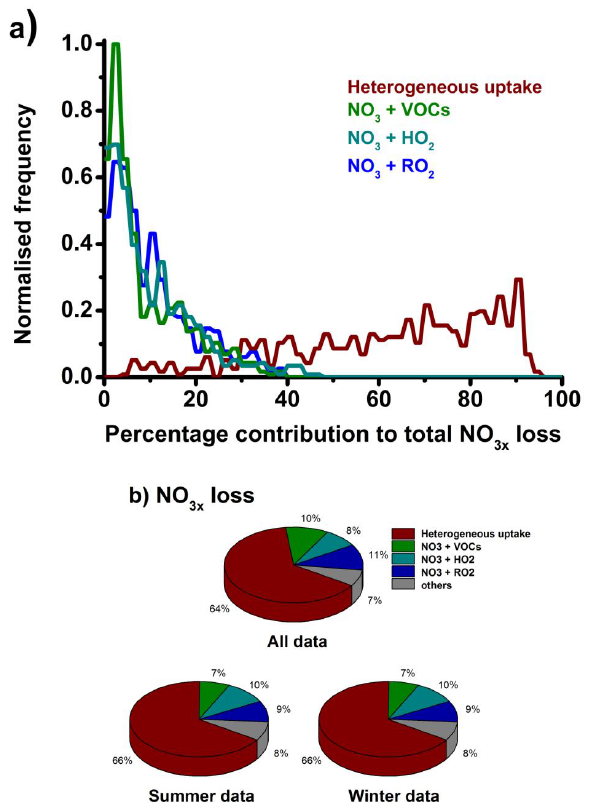
Fig. 6. Processes controlling losses of NO 3x (i.e. NO 3 + N 2 O 5 ) in the model, displayed as (a) the probability distribution func- tions for the percentage contributions to the total loss for hetero- Figure 6: Processes controlling losses of NO 3x (= NO 3 + N 2 O 5 ) in the model, displayed as (a) the geneous uptake of NO 3x to aerosol surfaces (red), NO 3 + VOCs probability distribution functions for the percentage contributions to the total loss for heterogeneous (green), NO 3 + HO 2 (light blue) and NO 3 + RO 2 (all organic uptake of NO 3x to aerosol surfaces (red), NO 3 + VOCs (green), NO 3 + HO 2 (light blue) and NO 3 + RO 2 peroxy radicals) (dark blue); and (b) the summer and win- (all organic peroxy radicals) (dark blue), and (b) the summer and winter campaign means combined ter campaign means combined (upper panel), summer campaign (upper panel), summer campaign mean (lower panel, left hand side) and winter campaign mean (lower mean (lower panel, left hand side) and winter campaign mean panel, right hand side). The average total loss rate of NO 3x was (7.8 ± 6.9) × 10 5 cm 3 s -1 (median = 5.5 (lower panel, right hand side). The average total loss rate of × 10 5 cm 3 s -1 ) for the entire data set, (7.6 ± 6.6) × 10 5 cm 3 s -1 (median = 5.5 × 10 5 cm 3 s -1 ) for the NO 3x was (7.8 ± 6.9) × 10 5 cm − 3 s − 1 (median = 5.5 × 10 5 cm − 3 summer campaign and (8.2 ± 7.7) × 10 5 cm 3 s -1 (median = 6.0 × 10 5 cm 3 s -1 ) for the winter campaign. s − 1 ) for the entire data set, (7.6 ± 6.6) × 10 5 cm − 3 s − 1 (me- dian = 5.5 × 10 5 cm − 3 s − 1 ) for the summer campaign and (8.2 ± 7.7) × 10 5 cm − 3 s − 1 (median = 6.0 × 10 5 cm − 3 s − 1 ) for the winter